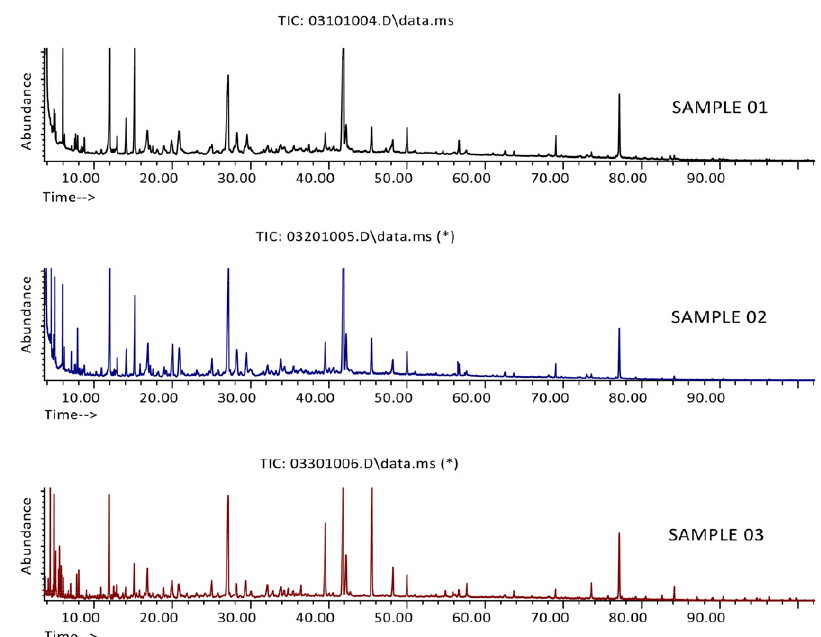
Figure 3. Comparison of the total ion chromatogram (TIC) between samples 01, 02 and